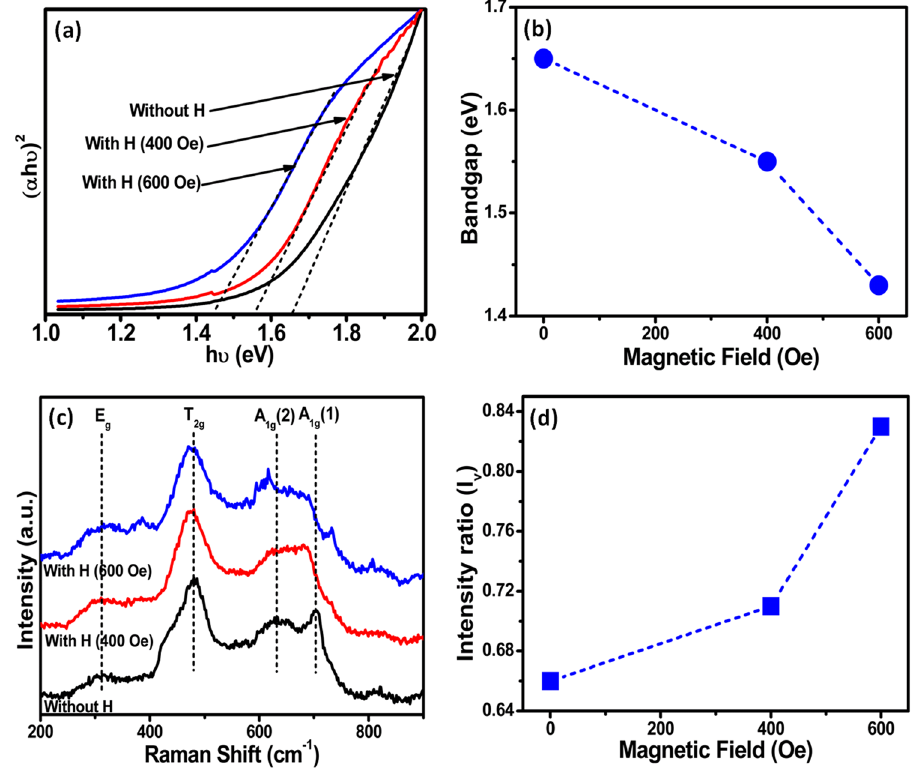
Figure 3. ( a ) Optical bandgap results of CoFe 2 O 4 nanostructure film under different magnetic field strengths, ( b ) variation of bandgap with magnetic field, ( c ) Raman spectroscopy results of CoFe 2 O 4 film under different magnetic field strengths, ( d ) variation of intensity ratio (I v ) with magnetic